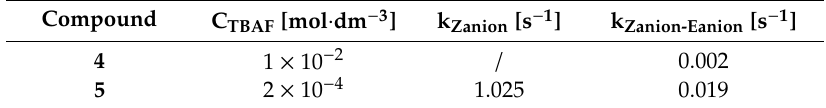
Table 3. Z anion formation rate constants k Z anion [s − 1 ] and Z anion = E anion thermal isomerization